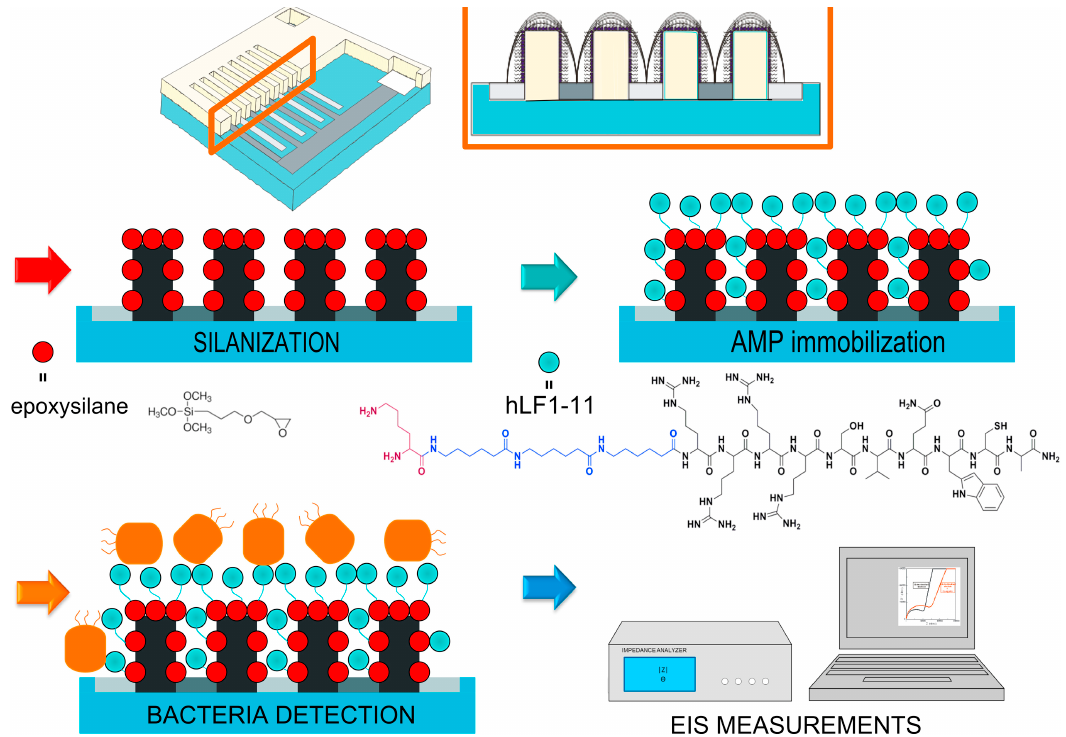
Figure 6. Schematic representation of the biosensor design and its functionalization with the hLF1-11 peptide. 3D-IDEA electrodes were silanized in vapor phase with an epoxysilane. The hLf1-11 peptide contains 3 parts: (i) an antibacterial domain (black), (ii) a spacer unit (blue), and (iii) a lysine residue that acts as anchoring moiety (violet). The binding of S. sanguinis to the AMP-coated surface is measured by EIS technique. Reprinted from [104], with permission from Elsevier. © 2016 Elsevier B.V.